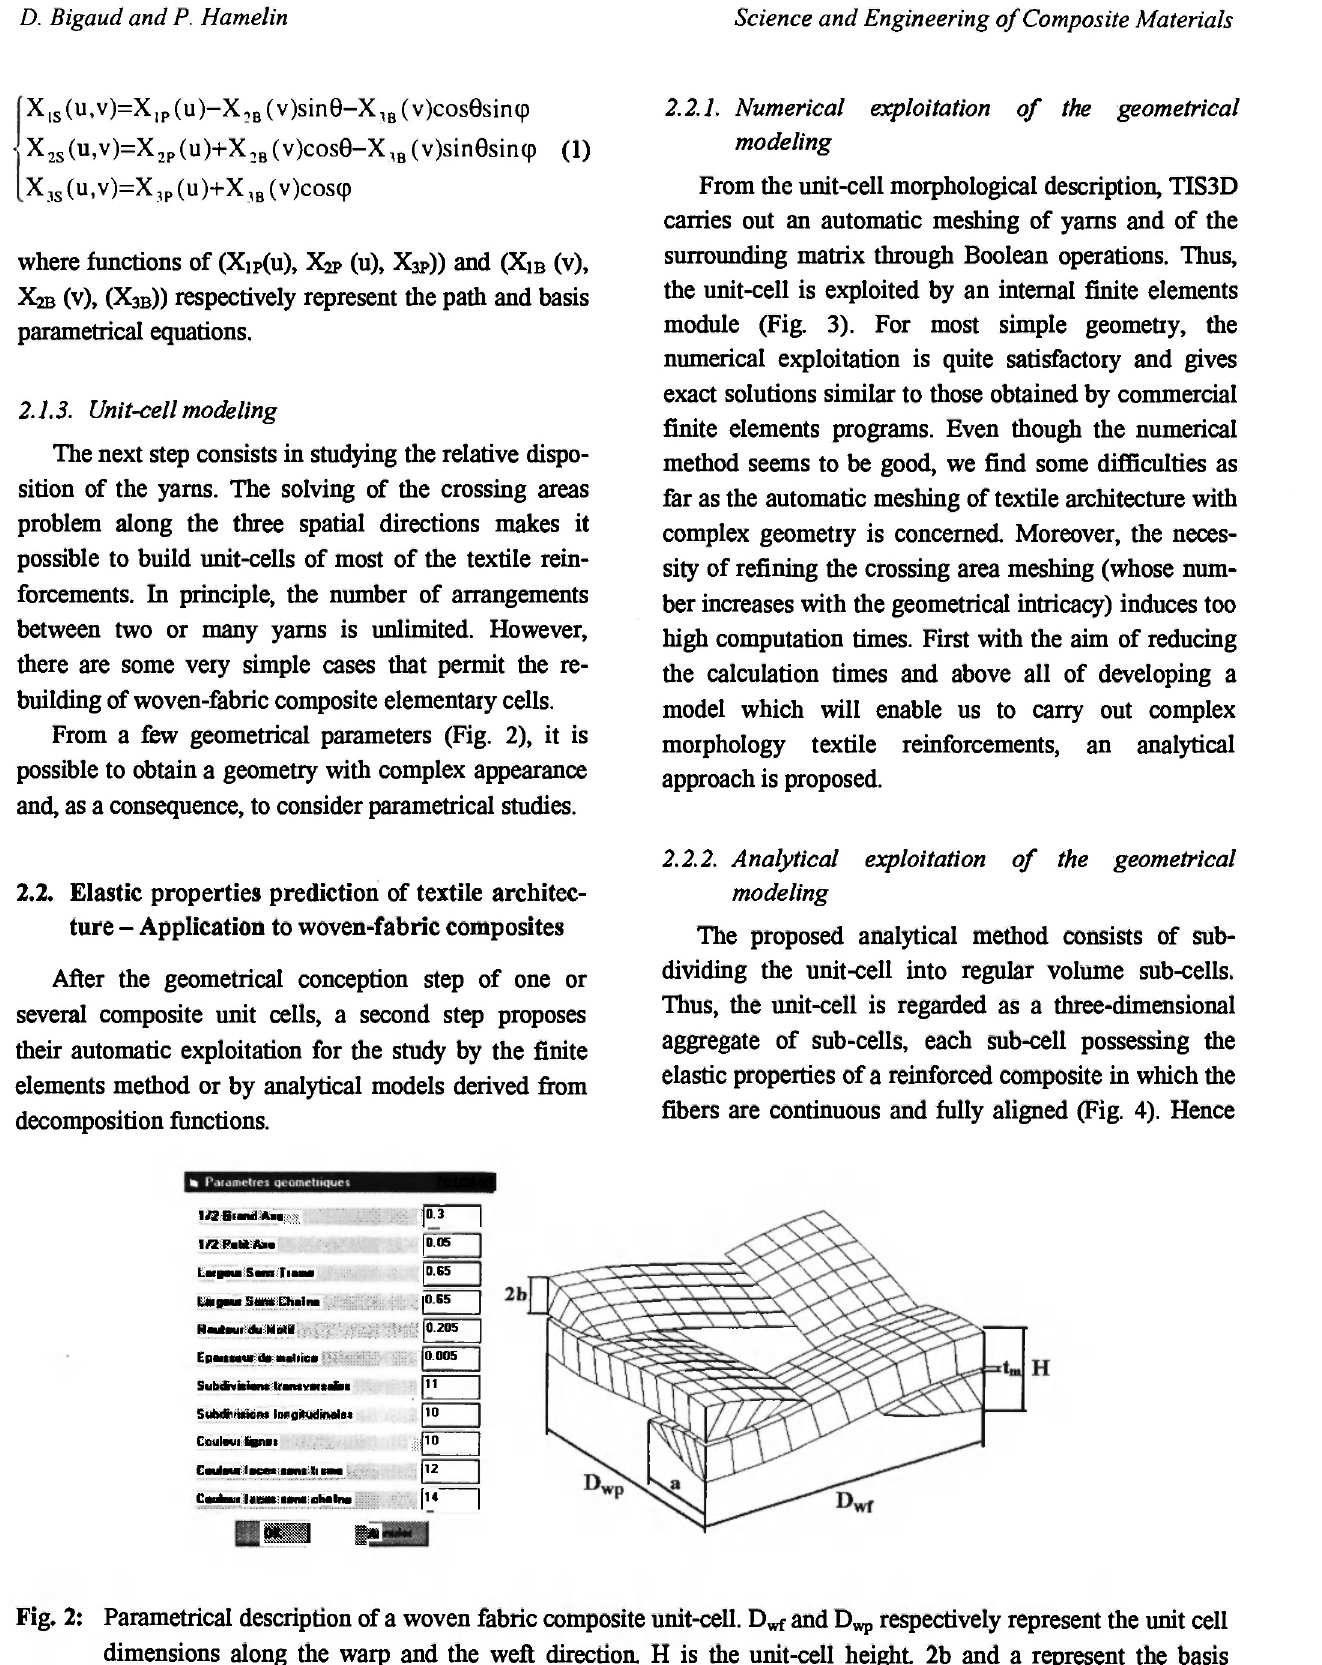
Fig. 2: Parametrical description of a woven fabric composite unit-cell. Dwf and D^ respectively represent the unit cell dimensions along the warp and the weft direction Η is the unit-cell height 2b and a represent the basis geometrical parameters, tm is the thickness of the matrix between the warp and weft